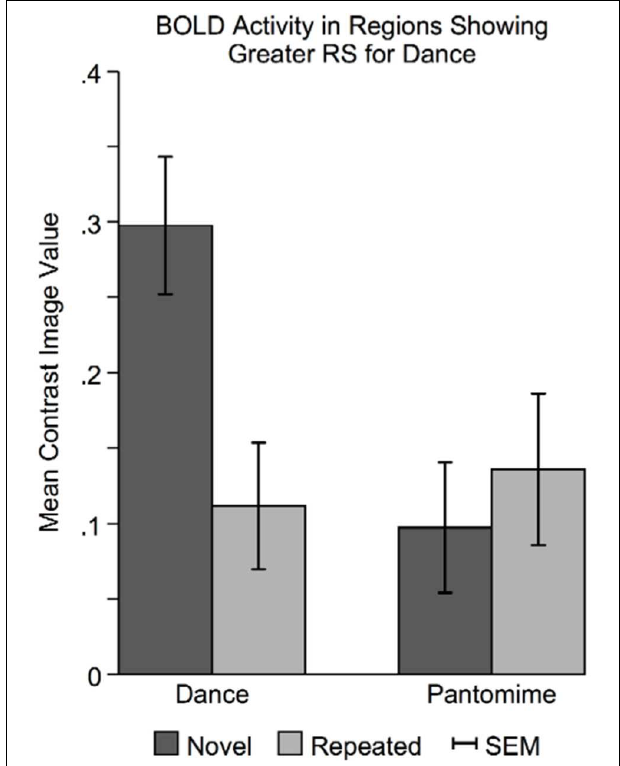
FIGURE 7 | Novel danced themes challenge brain substrates that decode meaning from movement. To determine the specific pattern of BOLD activity that resulted in greater RS for dance, average BOLD activity in these areas was computed for each condition separately. Greater RS for dance was driven by a larger BOLD response to novel danced themes. Considered together with behavioral findings indicating that dance was more difficult to interpret, greater RS for dance seems to result from a greater processing “challenge” to brain substrates involved in decoding meaning from movement. SEM, standard error of the